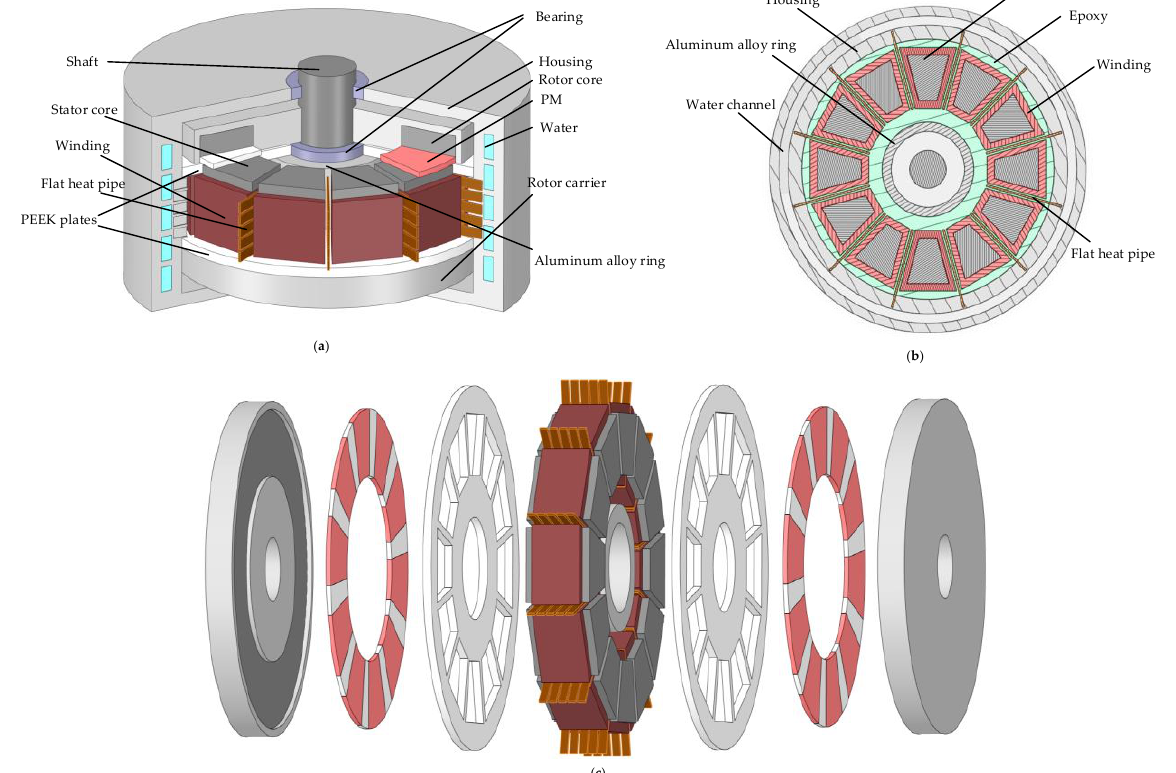
Figure 3. Stator cooling structure for YASA. ( a ) Overall structure. ( b ) Cross-section view of the stator. ( c ) Exploded view.